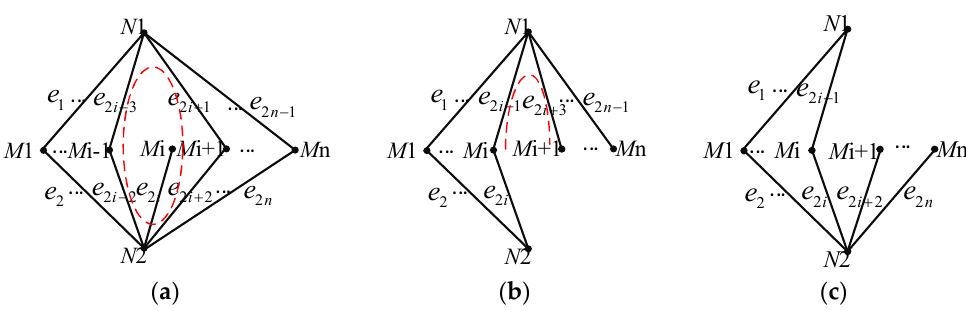
Figure 8. Connection diagram in different feeding conditions ( a ) UDP ( b ) SLAT ( c ) SLTR. The UDP feeding condition depends on whether the connection diagram form a closed loop.